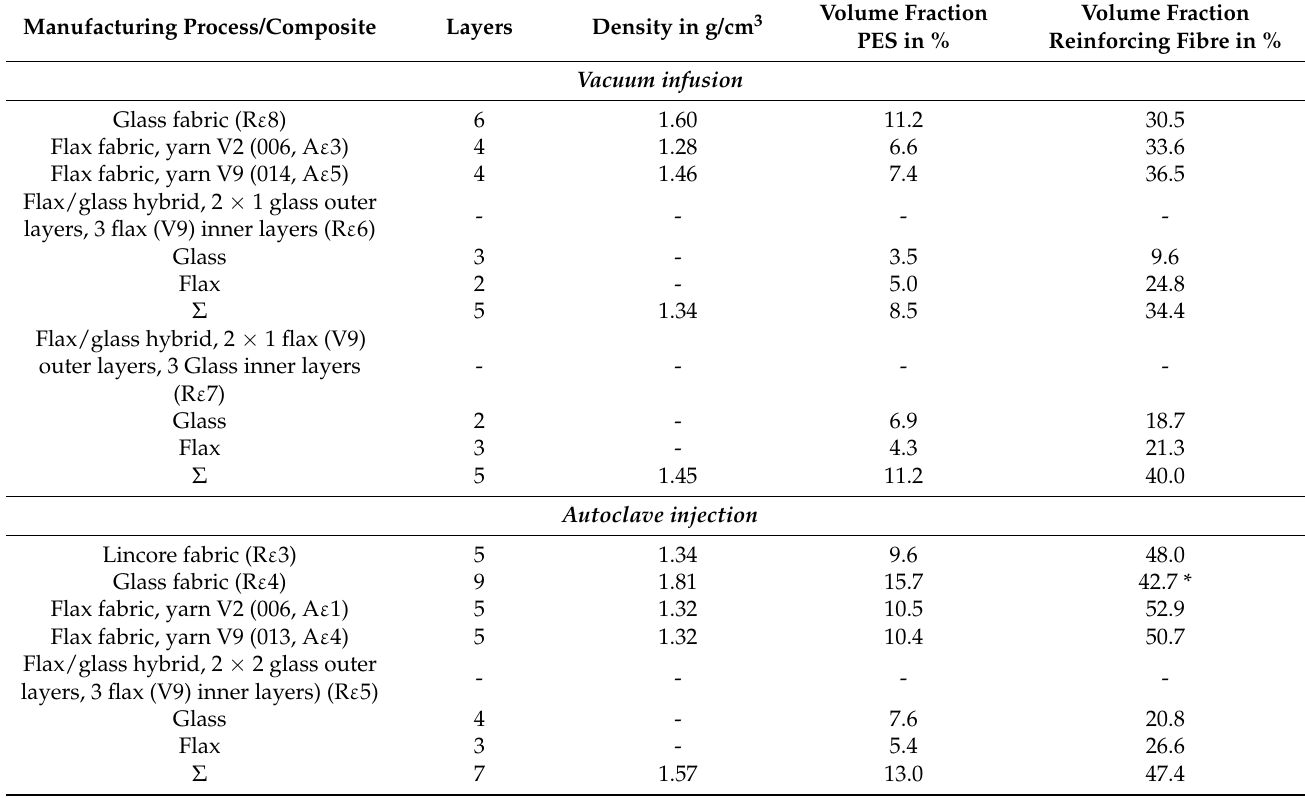
Table 4. Composition, density, volume fraction of polyester (PES) warp threads and calculated fibre volume fraction of composites produced by vacuum infusion and autoclave injection processes (designations in brackets with Greek letters indicate internal labels which are used for the classification of the samples in the project).